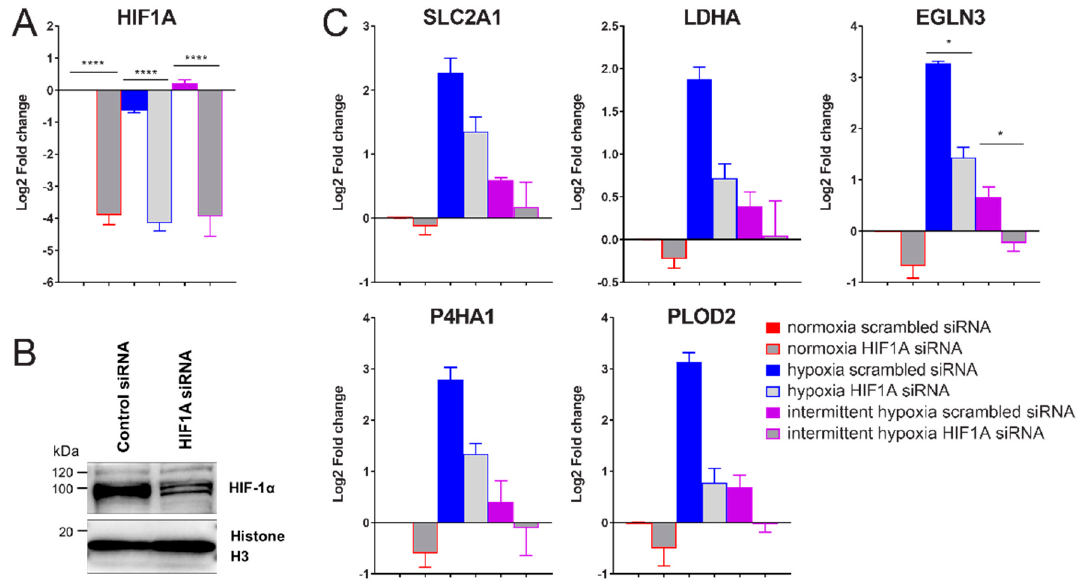
Figure 4. HIF1A siRNA mediated knockdown reduces intermittent hypoxia-driven increases in